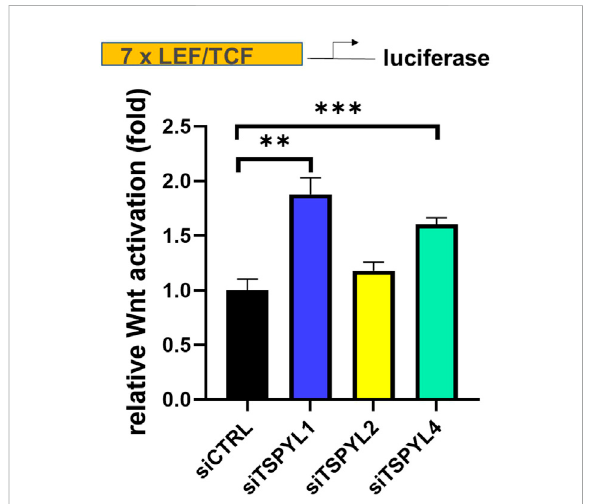
FIGURE 2 TSPYL1,2and4regulateWntsignaling activity.Knockdownof TSPYL1, or TSPYL4 resulted in an increase in Wnt signaling activity. Luciferase assays using a SuperTopFlash HEK293 cell line (STF reporter cells) which contains a luciferase reporter under the control of 7 LEF/TCF binding sites, utilizes the SuperTopFlash system, with or without TSPYL1, 2, or 4 knock down. Error bars indicate standard deviations among 3 technical replicates